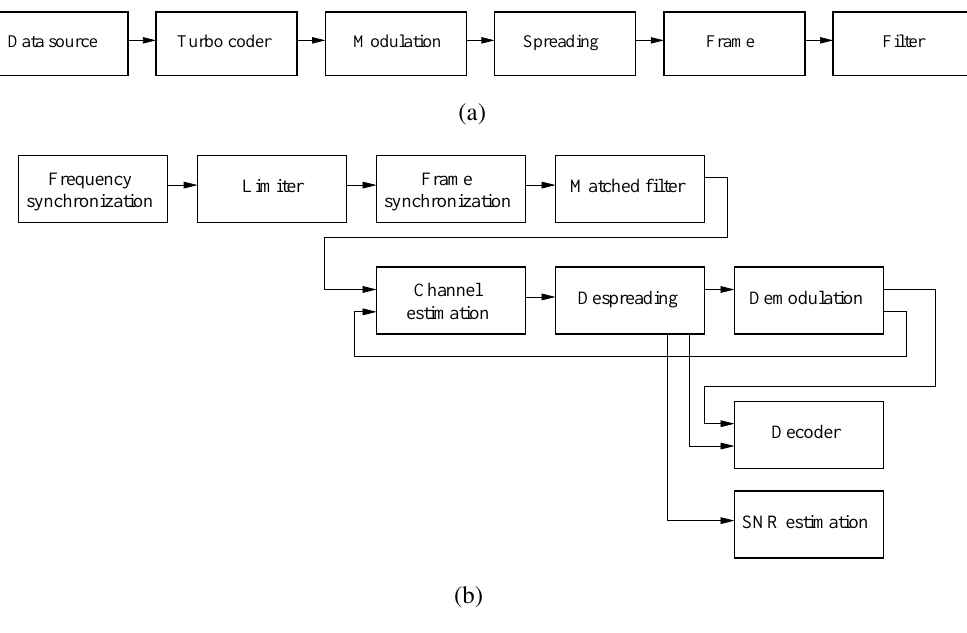
Figure 4. DS-SS signaling emitter (a) and receiver (b) block